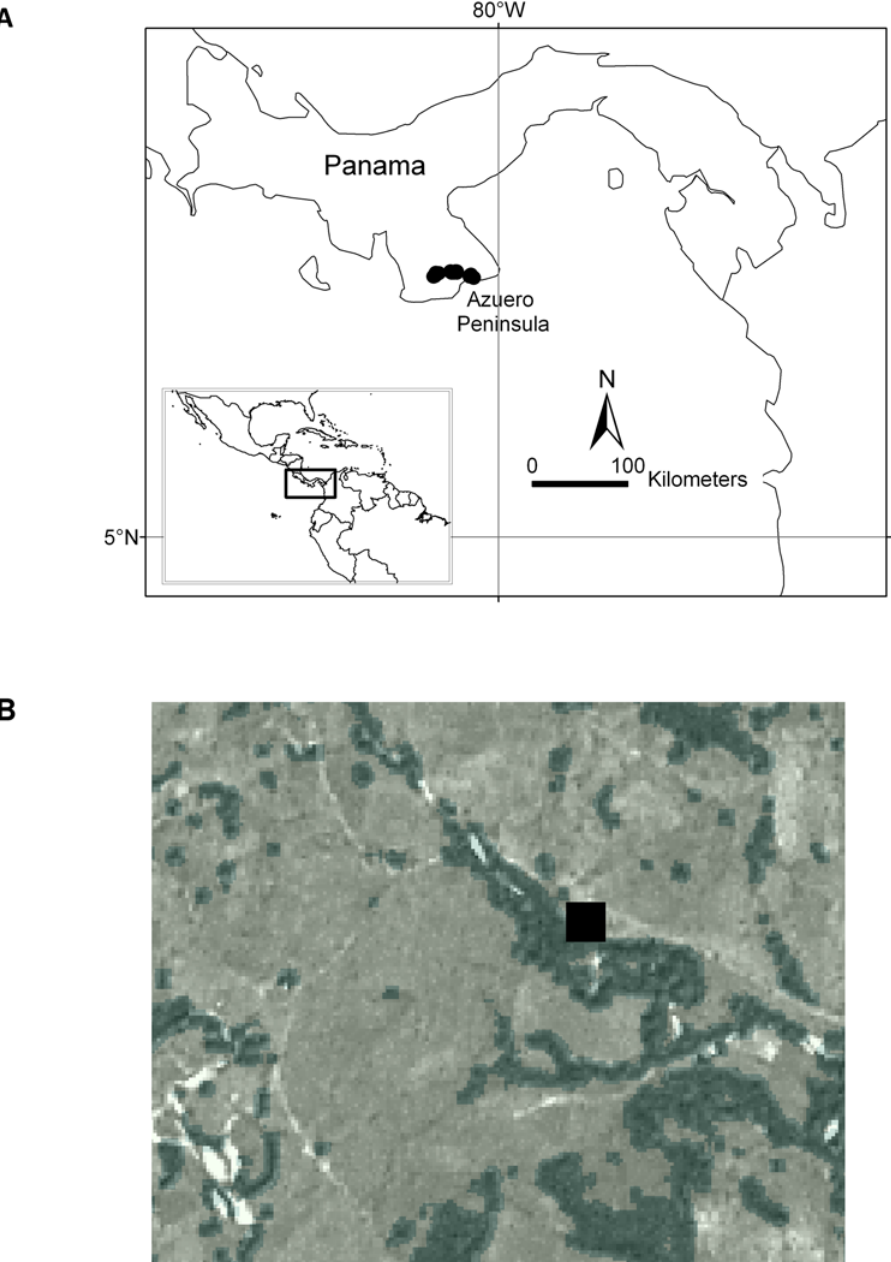
Figure 1. Study sites in the Azuero Peninsula Panama. The 24 study sites were located in edges of small fragments of forest in the Azuero Peninsula Panama. The satellite image indicates, as an example, the location of El Cortezo site; note the fragmented nature of the landscape and the location of the sampling grid (black square) in the forest – grassland edge.